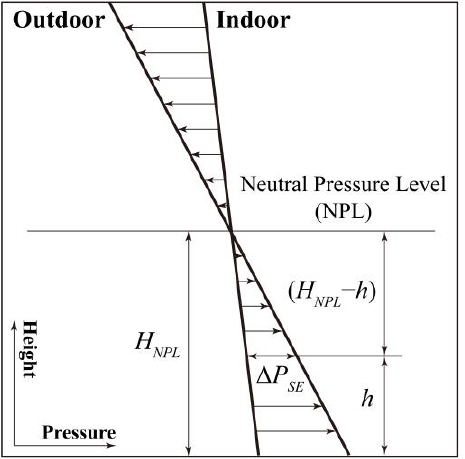
Figure 1. Indoor and outdoor absolute pressure profiles by stack effect.